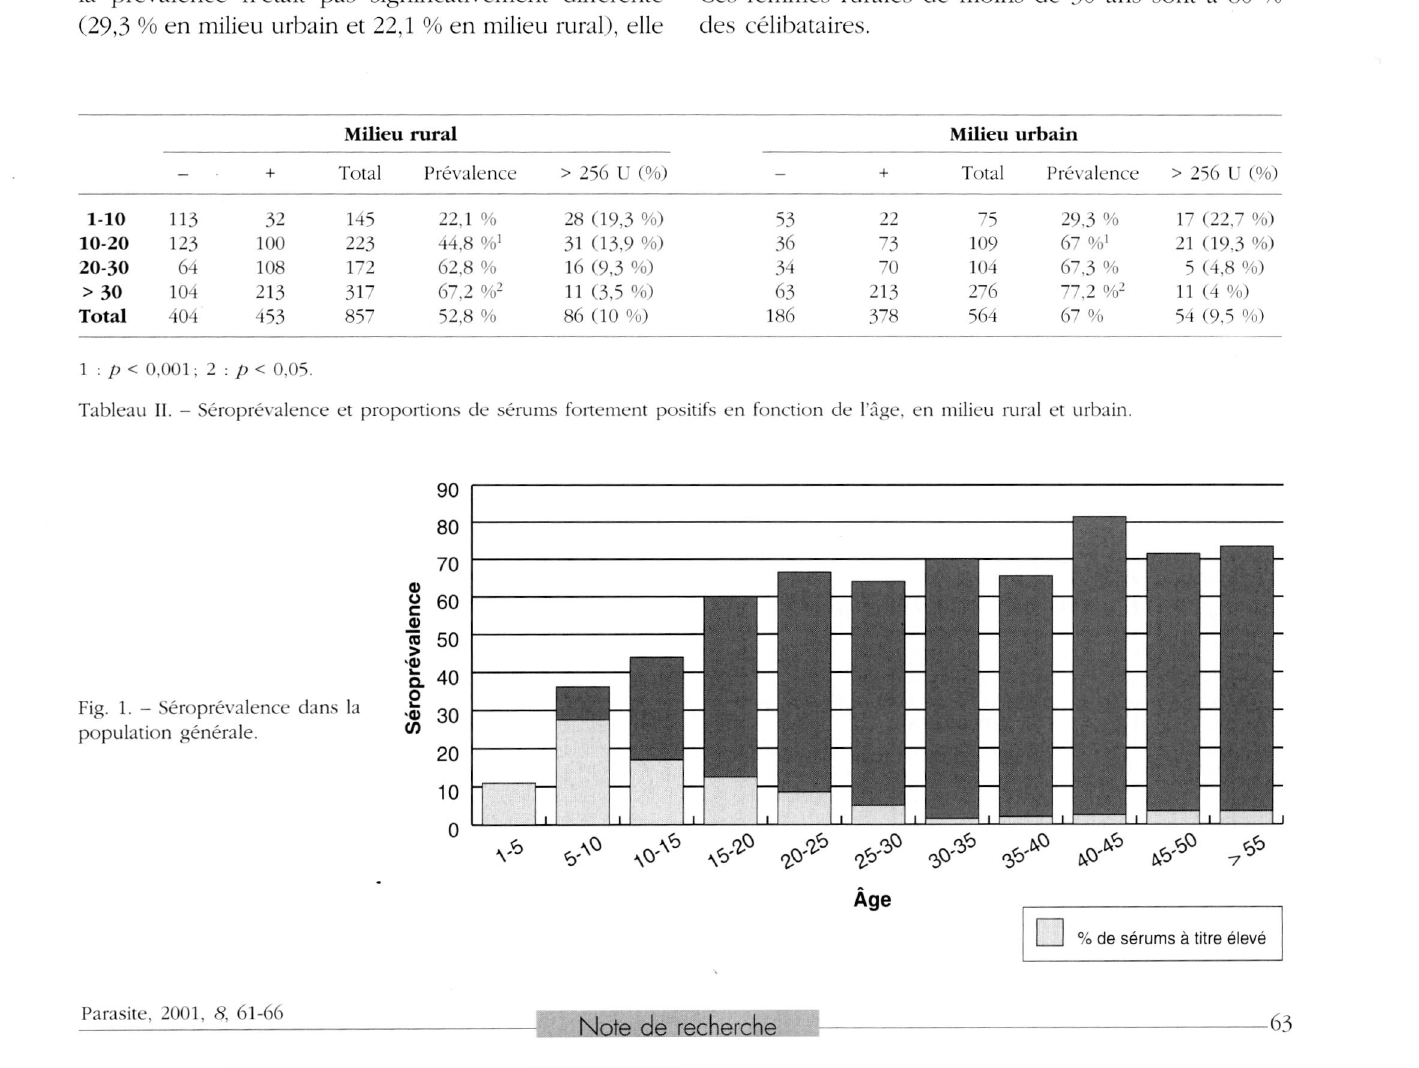
sans une analyse des effectifs par classe d'âge. En